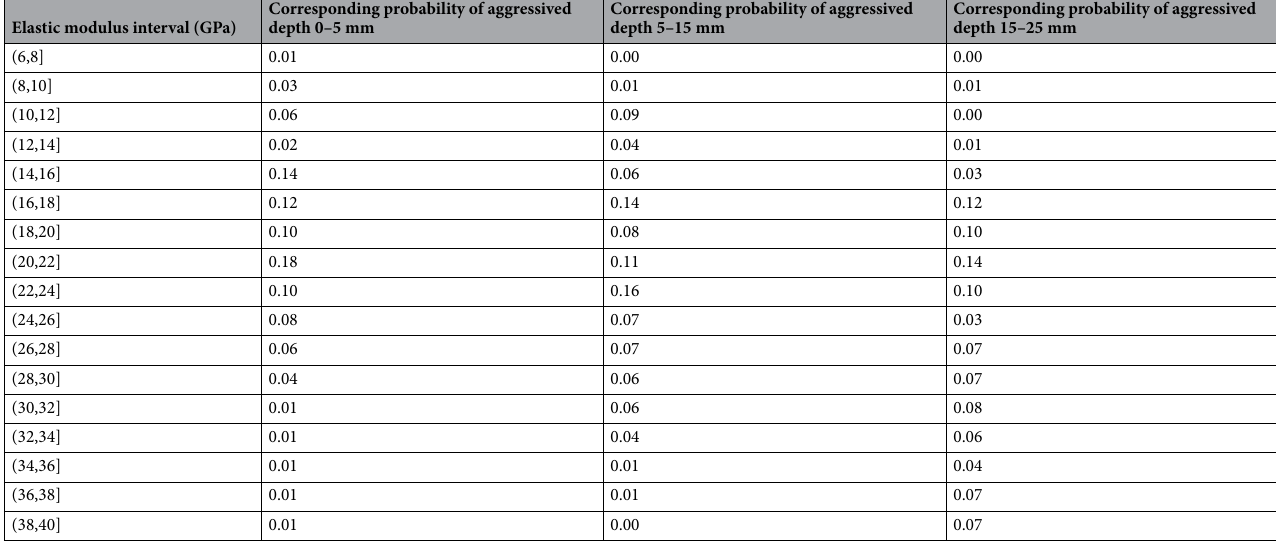
Table 4. Probability distribution of the elastic modulus at different aggressived depths for group HLLN.